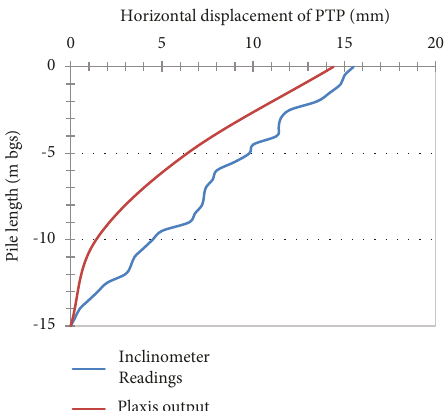
Figure 19: Relative displacement versus inclinometer displacement values of